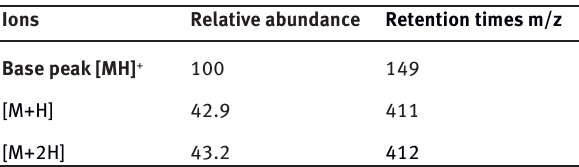
Figure 3: GC-MS chromatogram of Bensulfuron-methyl main peak at 12.7 R main degradation products of BSM at 149 and 182 Table 4: Ions selected for SCAN with their retention times and relative abundances for BSM molecular weight 410.